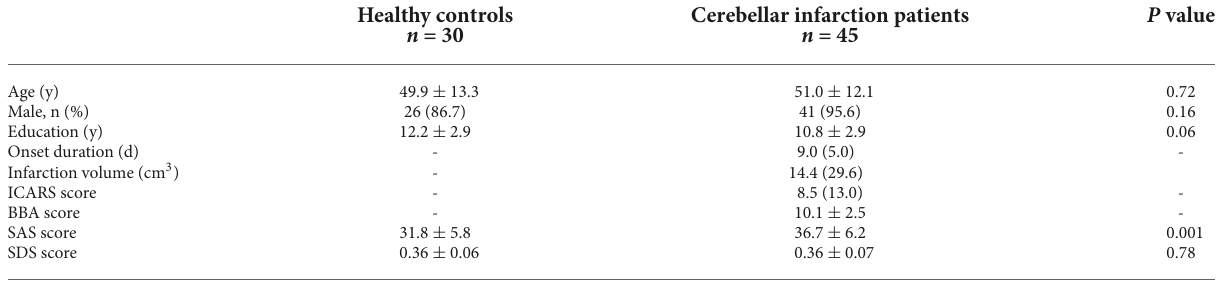
TABLE 1 Demographic characteristics of controls and cerebellar infarction patients.